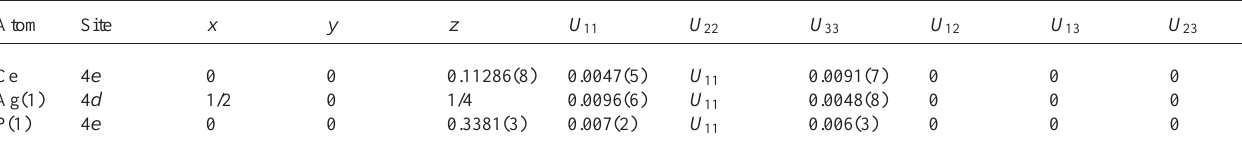
Table 3. Atomic coordinates and displacement parameters (in Å 2 ) .